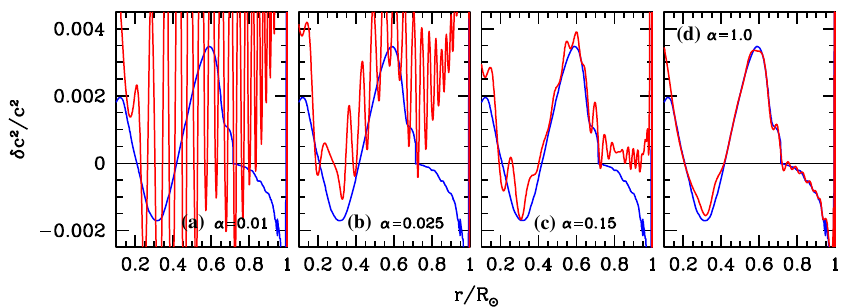
Fig. 12 The relative sound-speed differences between two solar models obtained by inverting their fre- quency differences using the RLS technique. In each panel the blue line is the true difference between the models and the red line is the inversion result. The different panels show the result obtained using different values of the smoothing parameter α . The reference model used is model BP04 of Bahcall et al. (2005a) and the test model, or proxy Sun, is model BSB(GS98) of Bahcall et al. (2006). We only used those modes that have been observed in the Sun, specifically mode-set BiSON-13 of Basu et al. (2009). Random errors, corresponding to the uncertainties in the observed mode-set, were added to the data of the test